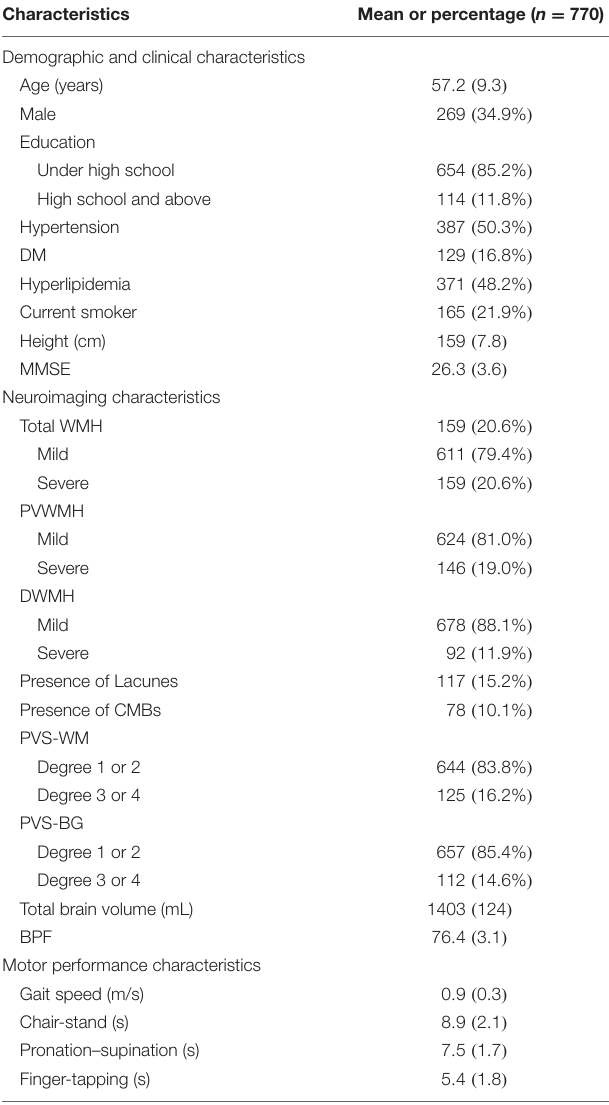
TABLE 1 | Baseline characteristics of the study population.